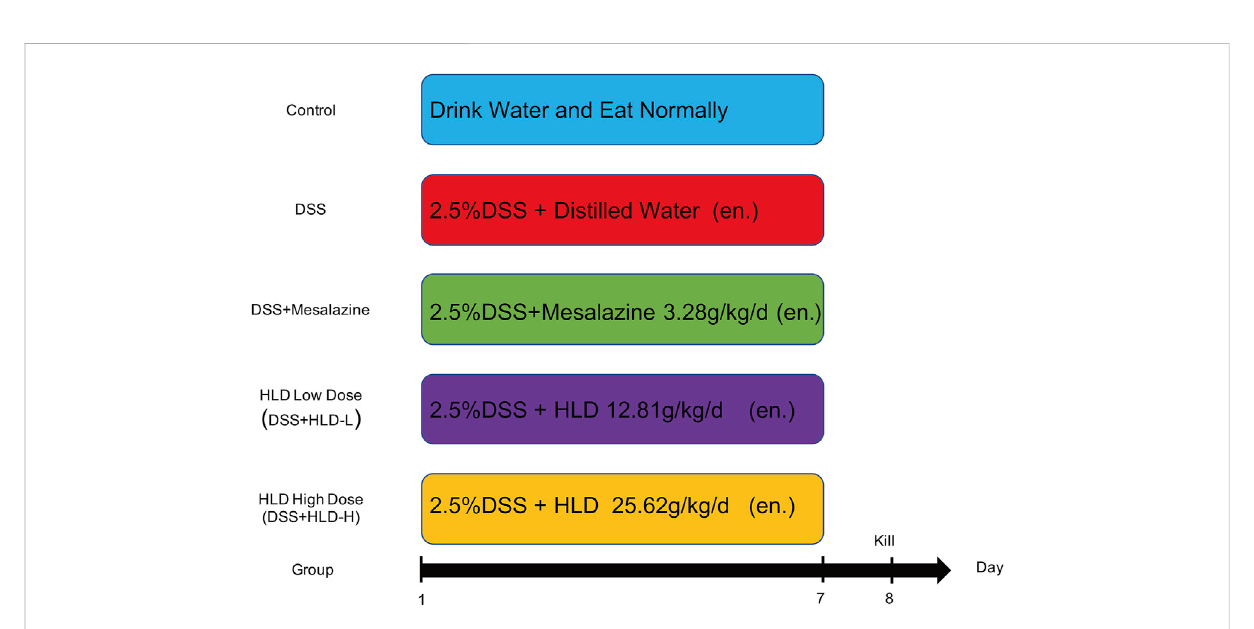
FIGURE 1 Experimental fl ow and drug delivery